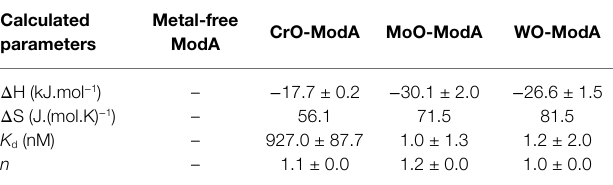
TABLE 2 | ITC analyses of metal-free and metal-bound ModA. Calculated Metal-free parameters